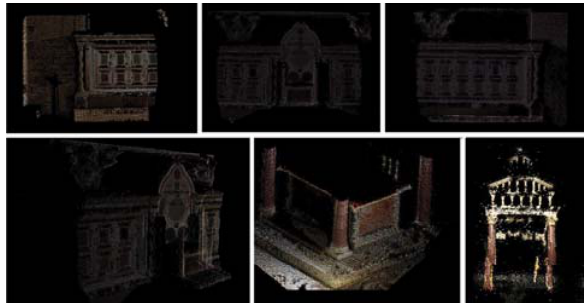
Figure 9. The image show the results with z-scan.